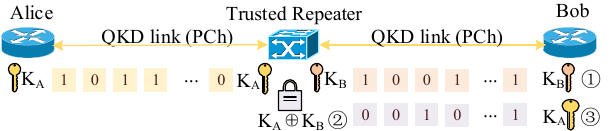
Figure 2. Trusted relays are used to extend QKD distance and ultimately generate end-to-end quantum keys.